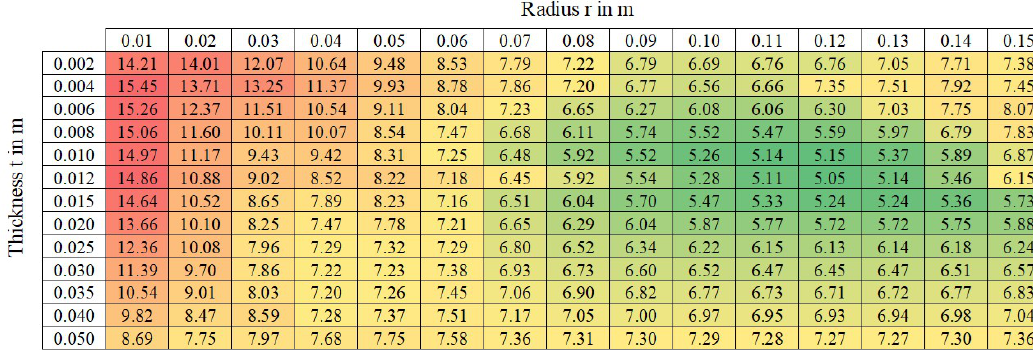
Figure 17. ACF values for various combinations of thickness t and radius r of the separation plate design. An optimized result is clearly